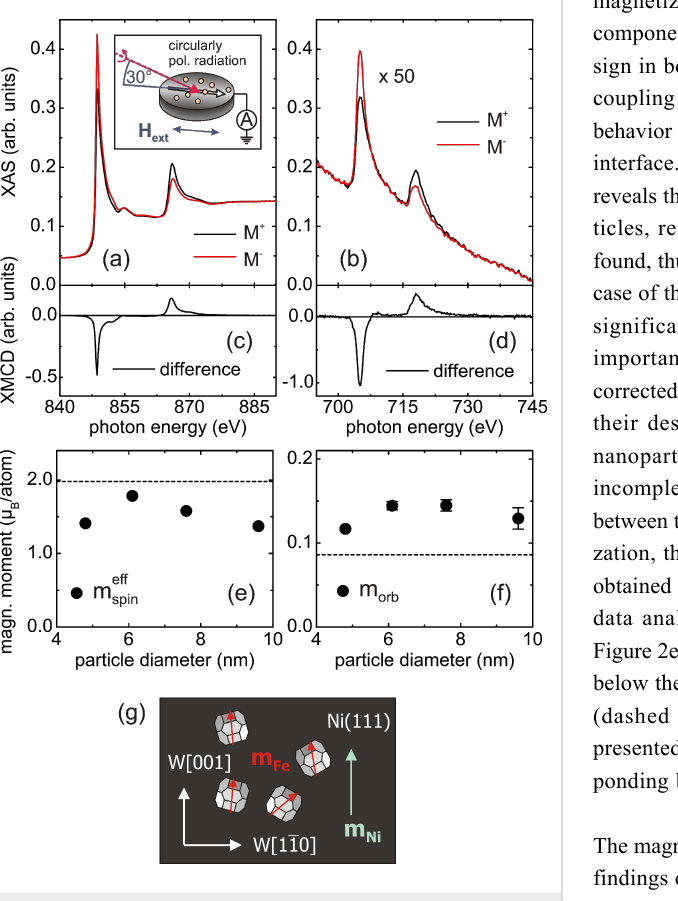
Figure 2c and Figure 2d show magnetic dichroism spectra (given by the difference of the XA spectra with